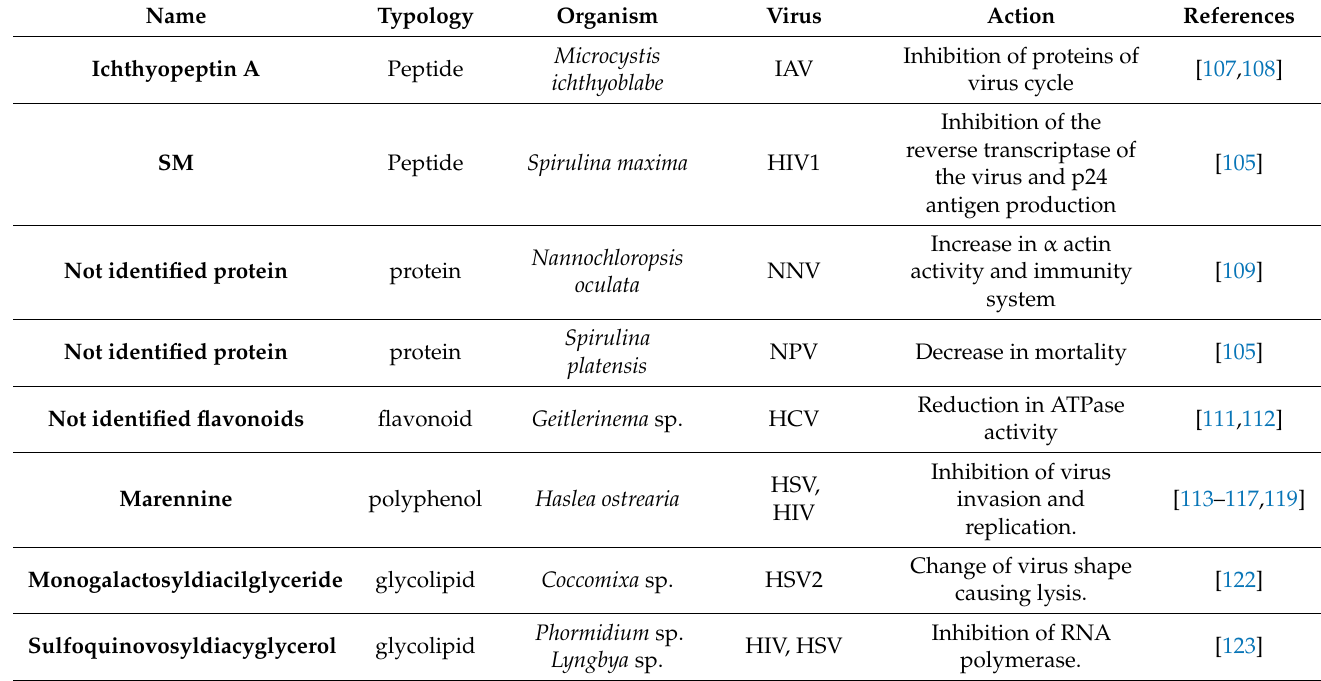
Table 4. Other microalgae compounds with antiviral